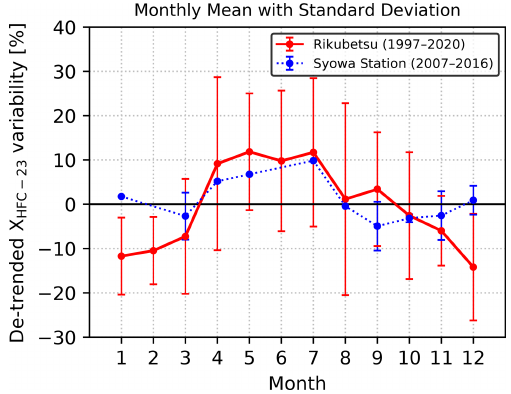
Figure 8. Seasonal cycles of the FTIR-retrieved X HFC-23 at Riku- betsu for the 1997–2020 period and at Syowa Station for the 2007– 2016 period. Year-to-year variability is shown as 1 σ standard devi- ation for each month. At Syowa Station, there are no observations in February and June and only 1 year of observations for January, May, July, and August; hence, no 1 σ standard deviations are plotted for these